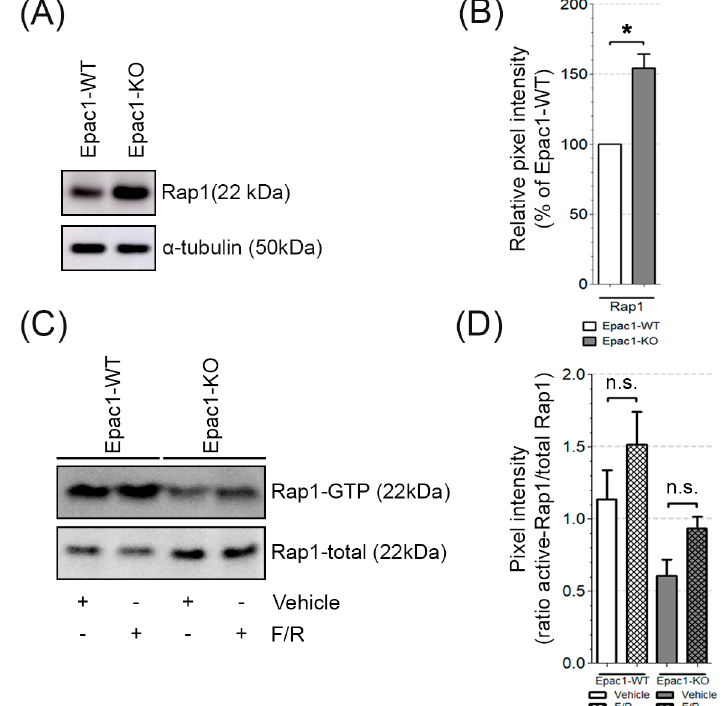
Figure 3. Basal and GTP-bound levels of Rap1. ( A ) Representative Western blot of total Rap1; α -tubulin was used as a loading control. N = 5, n ≥ 2. ( B ) Relative expression of Rap1 in Epac1-KO was compared to the respective expression in WT cells; * p ≤ 0.05. ( C ) Rap1 activation in WT and Epac1-KO cells, treated with either vehicle (DMSO) or F / R. The activity of Rap1 was assessed by pulldown assays; N = 4. ( D ) Densitometric measurements from the Rap1-GTP pull-downs were normalized to the respective total Rap1. “n.s.” denotes non-significant di ff